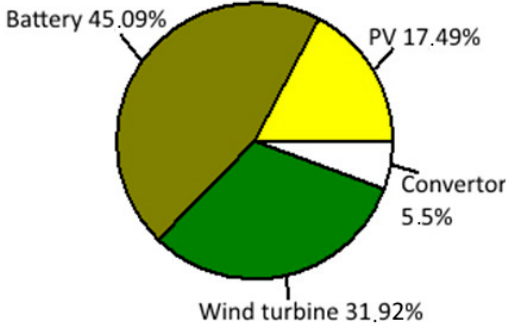
Figure 18. Analysis cost of the system for the third case using iHOGA.